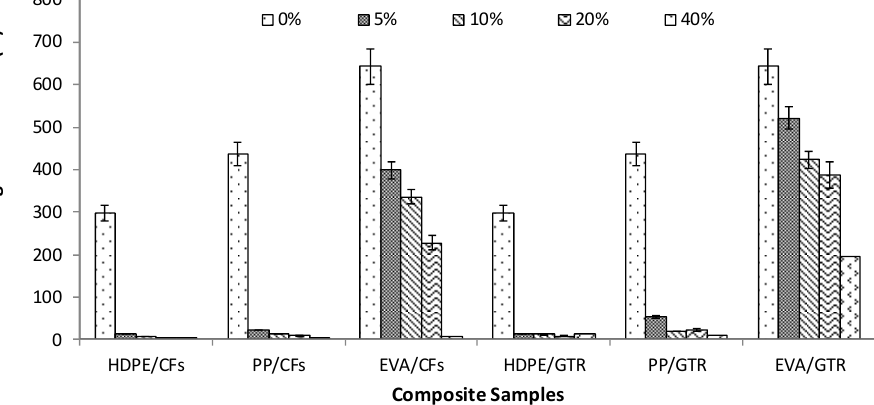
Figure 3. Elongation at break of the polymeric composites at compositions between 0 and 40% w / w .